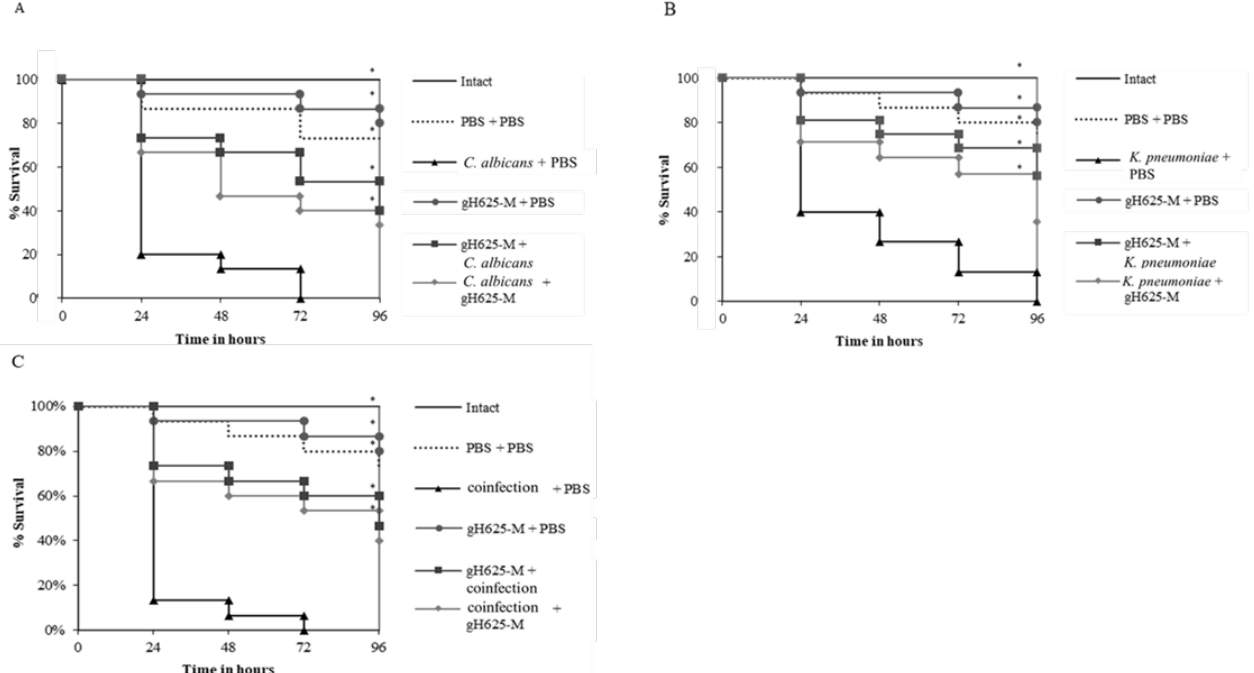
Figure 4. Kaplan–Meier plots of survival curves of G. mellonella larvae infected with C. albicans ( A ), K. pneumoniae ( B ), and co-infected with C. albicans + K. pneumoniae ( C ). In all panels, survival curves of larvae are shown. All groups were treated with 50 µ M gH625-M before or after infection/co-infection are reported. All groups were compared with control (infected or co-infected larvae). In all panels, survival curves of intact larvae, larvae injected with PBS, larvae injected with gH625 alone are reported. * represents p -value < 0.001 (log-rank test).